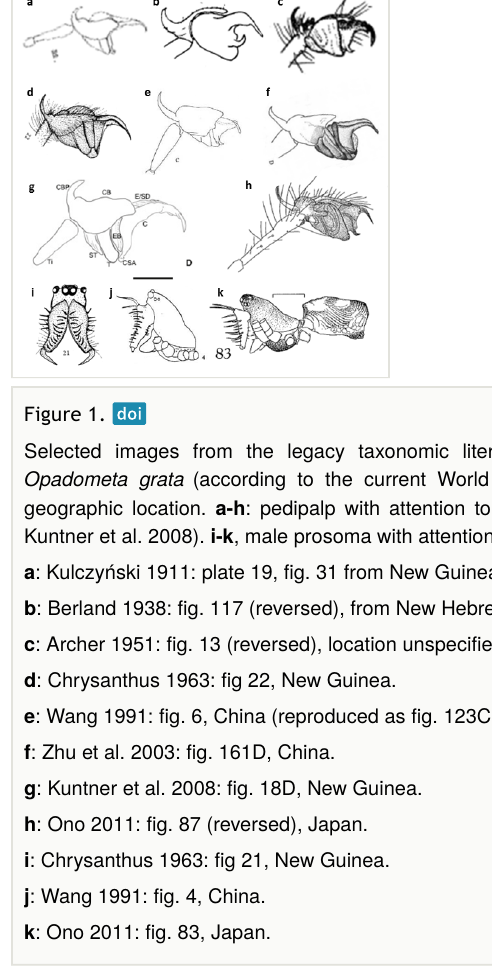
Males of Opadometa